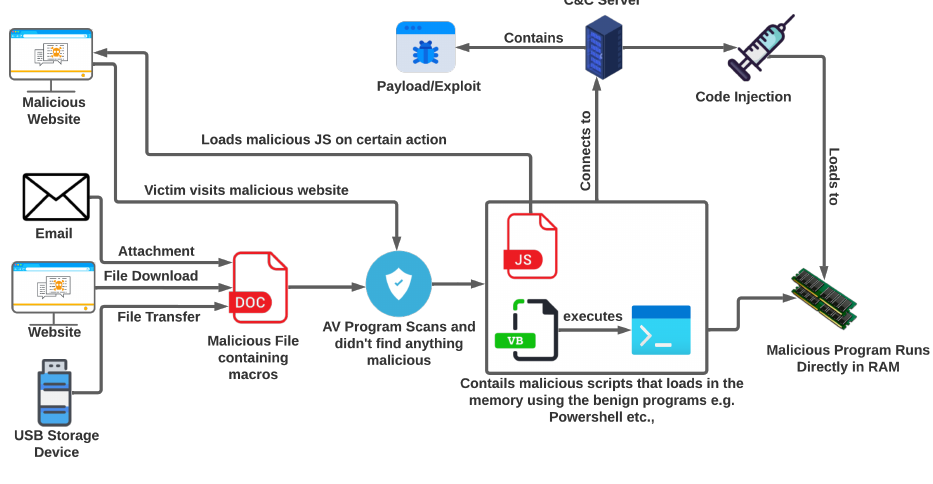
Figure 3. Fileless malware infection chain.